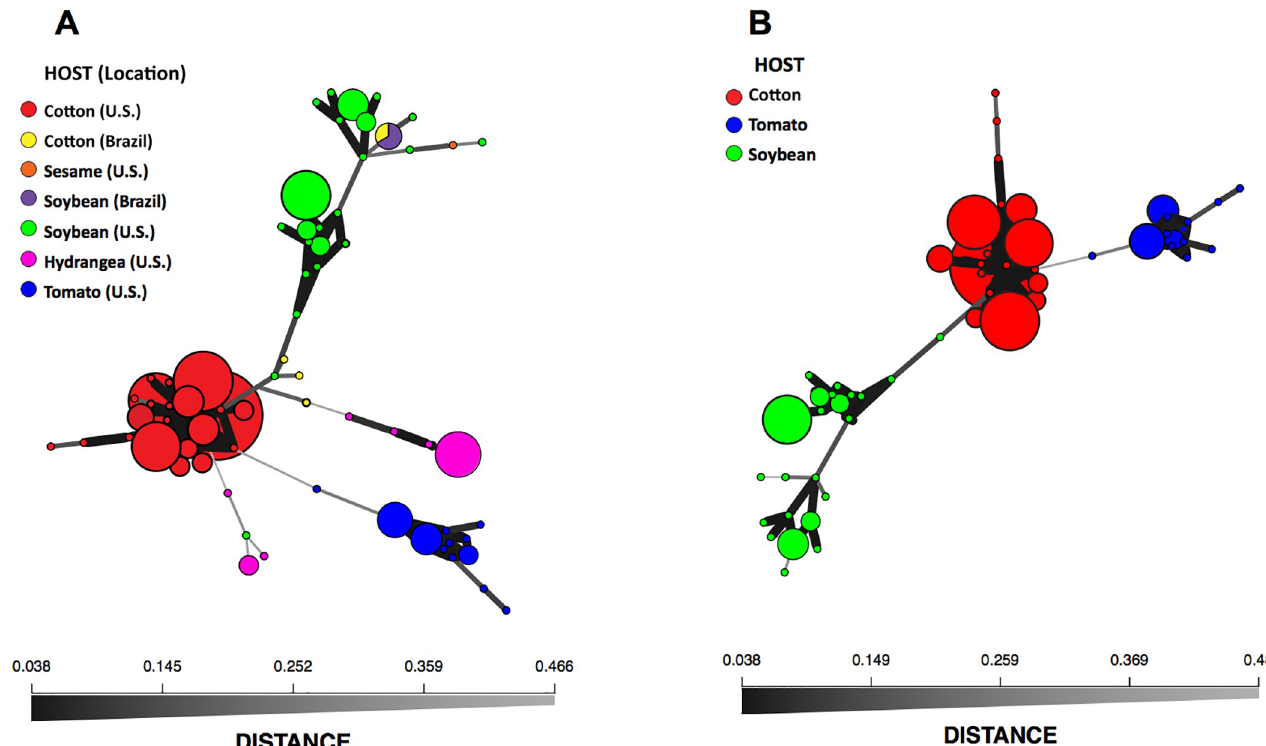
Fig 4. Minimum spanning networks based on Bruvo’s genetic distance for Corynespora cassiicola isolates from: A. cotton, soybean, tomato, hydrangea, cucumber, pepper, mandevilla, and sesame in the southeastern US and cotton and soybean in Brazil; and B. cotton, soybean, tomato, pepper, cucumber, and mandevilla in the southeastern US. Each node (circle) represents a unique haplotype with the size proportional to the frequency of the haplotype. The color shown for each haplotype represents the host species of origin. Edges (lines) represent minimum genetic distances between haplotypes determined by Prim’s algorithm. Nodes that are more closely related have thicker and darker edges, whereas nodes that are more distantly related have lighter and thinner edges. Cucumber, pepper, and mandevilla belong to the tomato population since they form the same cluster and share haplotypes